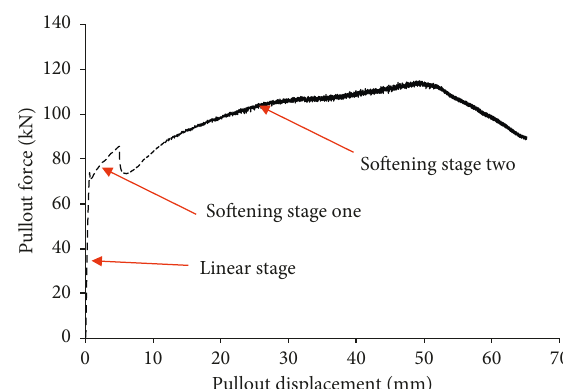
Figure 3: Typical load-displacement relationship of a plain cable bolt in DEPT.